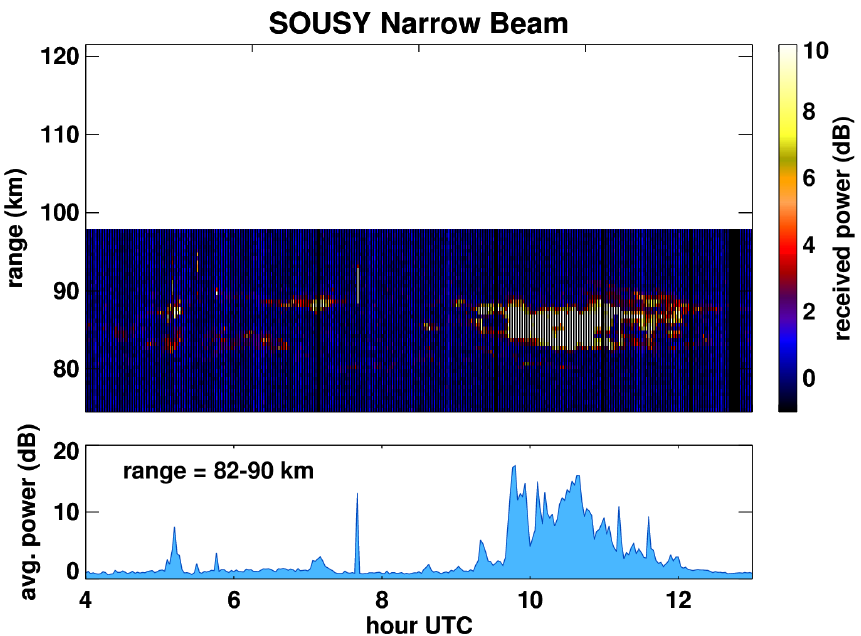
Figure 3. SSR narrow vertical beam received power for 19 July 2020: 1min averages in 0.5km range bins. Plot intensity has been capped at 10dB to enhance the visibility of weak features. Vertical striping is due to interleaving mesospheric observations with other experiments at 1min